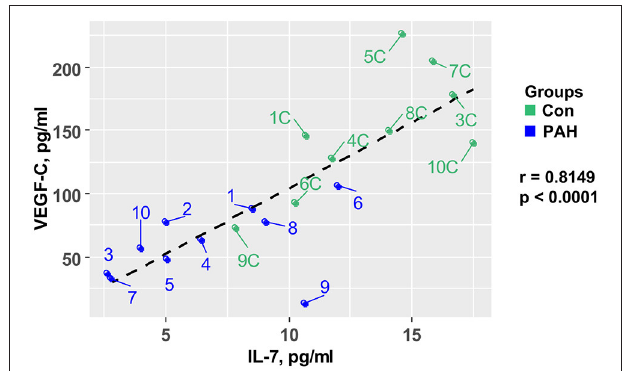
FIGURE 2 | Central-venous IL-7 in pediatric samples strongly positively correlates with VEGF-C. IL-7 plasma concentrations correlate with VEGF-C plasma concentrations measured in the superior vena cava (SVC) of 10 PH patients and 10 non-PH controls. Statistical test: Pearson. IL-7, interleukin-7; PH, pulmonary hypertension; VEGF-C, vascular endothelial growth factor